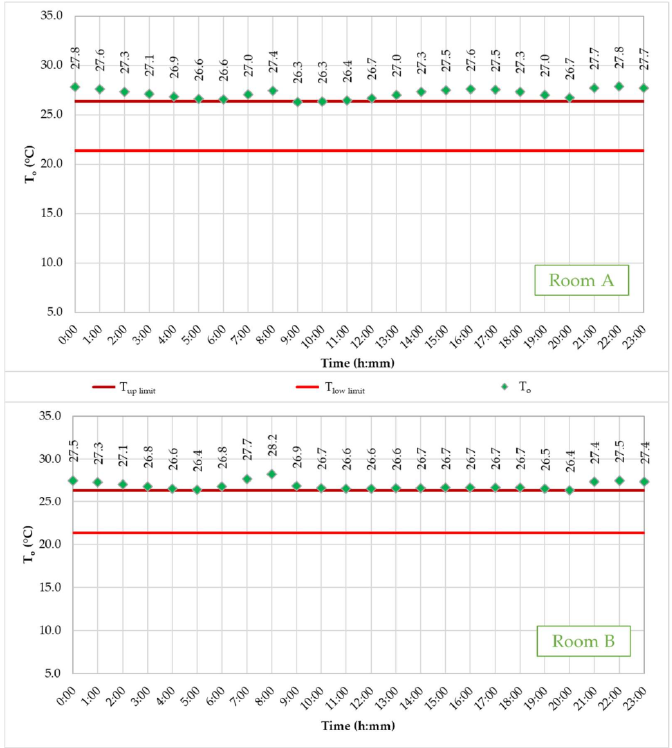
Figure 13. Hourly operative temperature for the summer day.